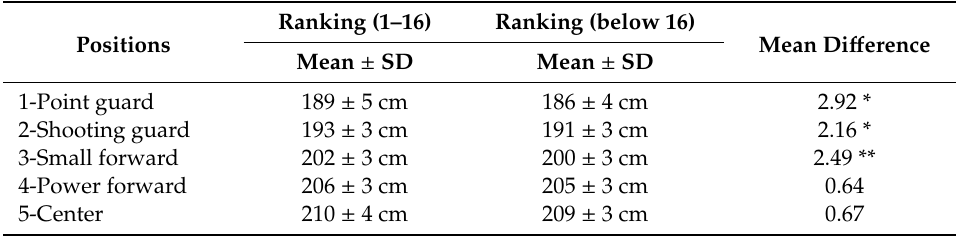
Table 2. Di ff erences in body height of players from the first 16 teams and below the 16 th place, relative to position in